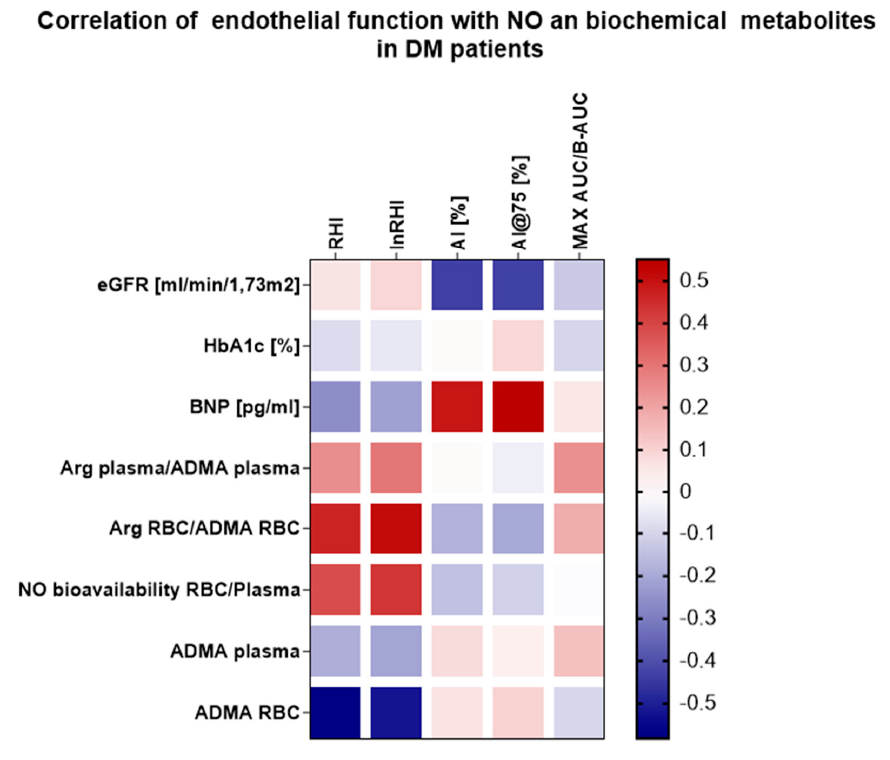
Figure 5. Correlation of endothelial function with NO and biochemical metabolites in DM patients.